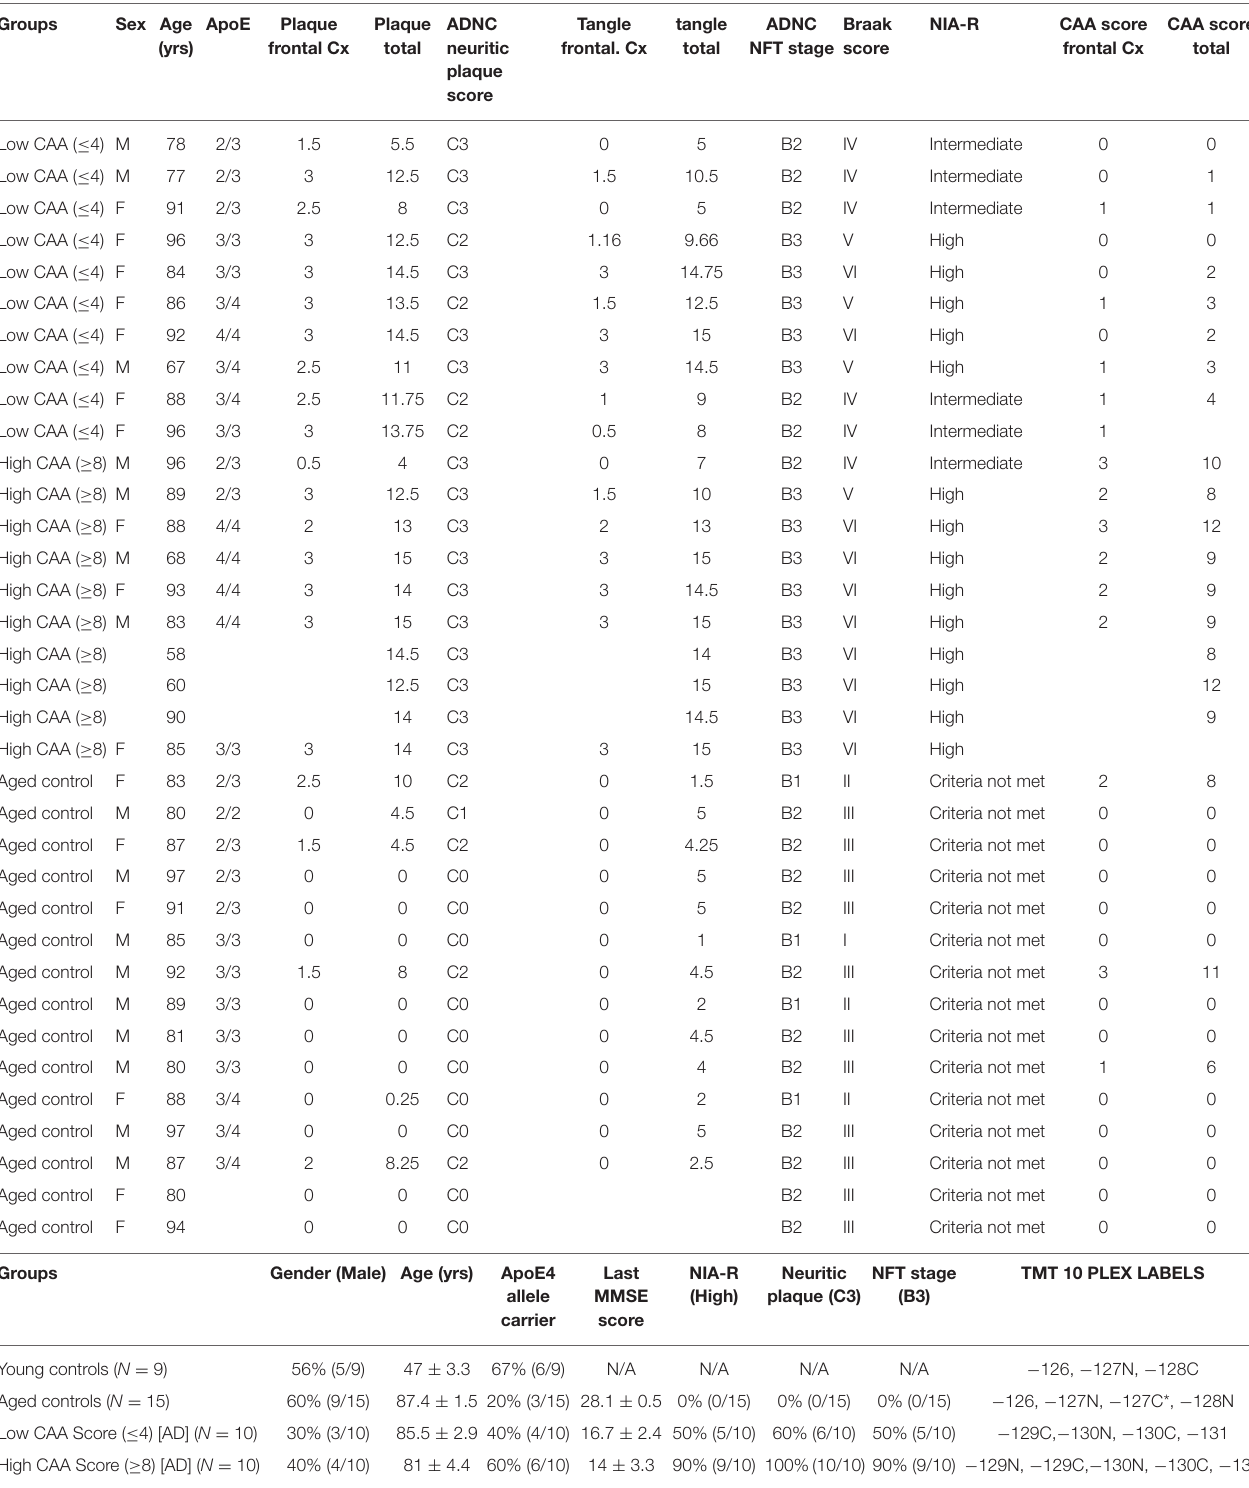
TABLE 1 | List of control and Alzheimer’s disease cases, their demographics, clinical background, APOE genotype, neuropathological score, and randomization of samples for Tandem Mass Tag isobaric 10-plex multiplexing.